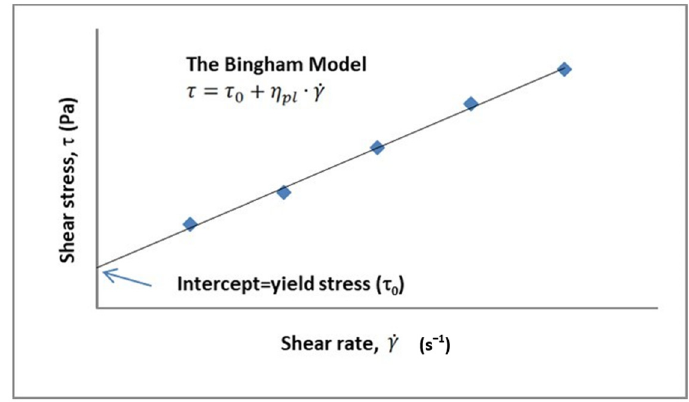
Figure 8. Bingham model [11]. Table 5. Results of Bingham data fitting of the rheological data of